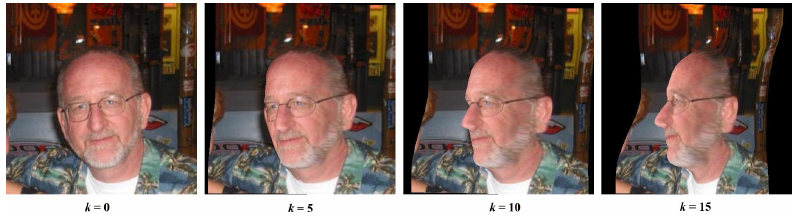
Figure 3. An example from the 300W-LP dataset; yaw angle rotated k number of